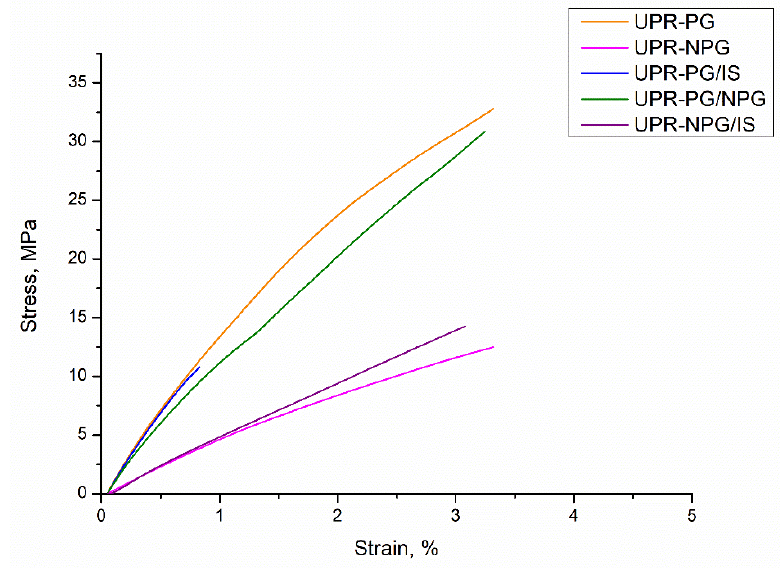
Figure 6. Stress–strain dependency for uniaxial tensile testing. Table 3. Tensile properties of the prepared UPRs.